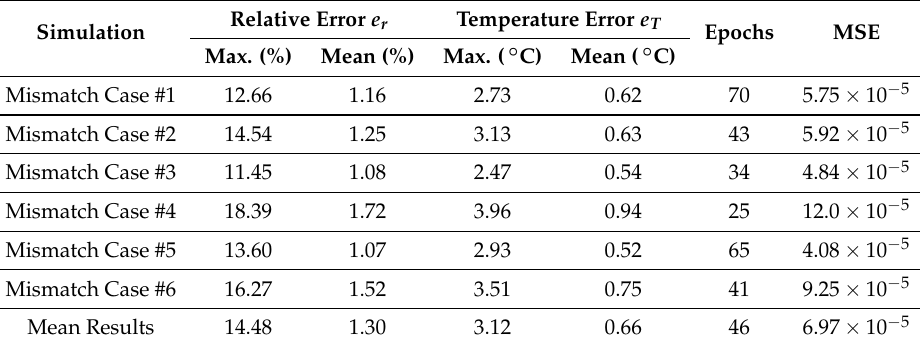
Figure 21. ( a ) Relative error e r and ( b ) error in the temperature estimation e T obtained when mismatch between neurons is considered. Table 7. Calculated errors considering six mismatch cases between